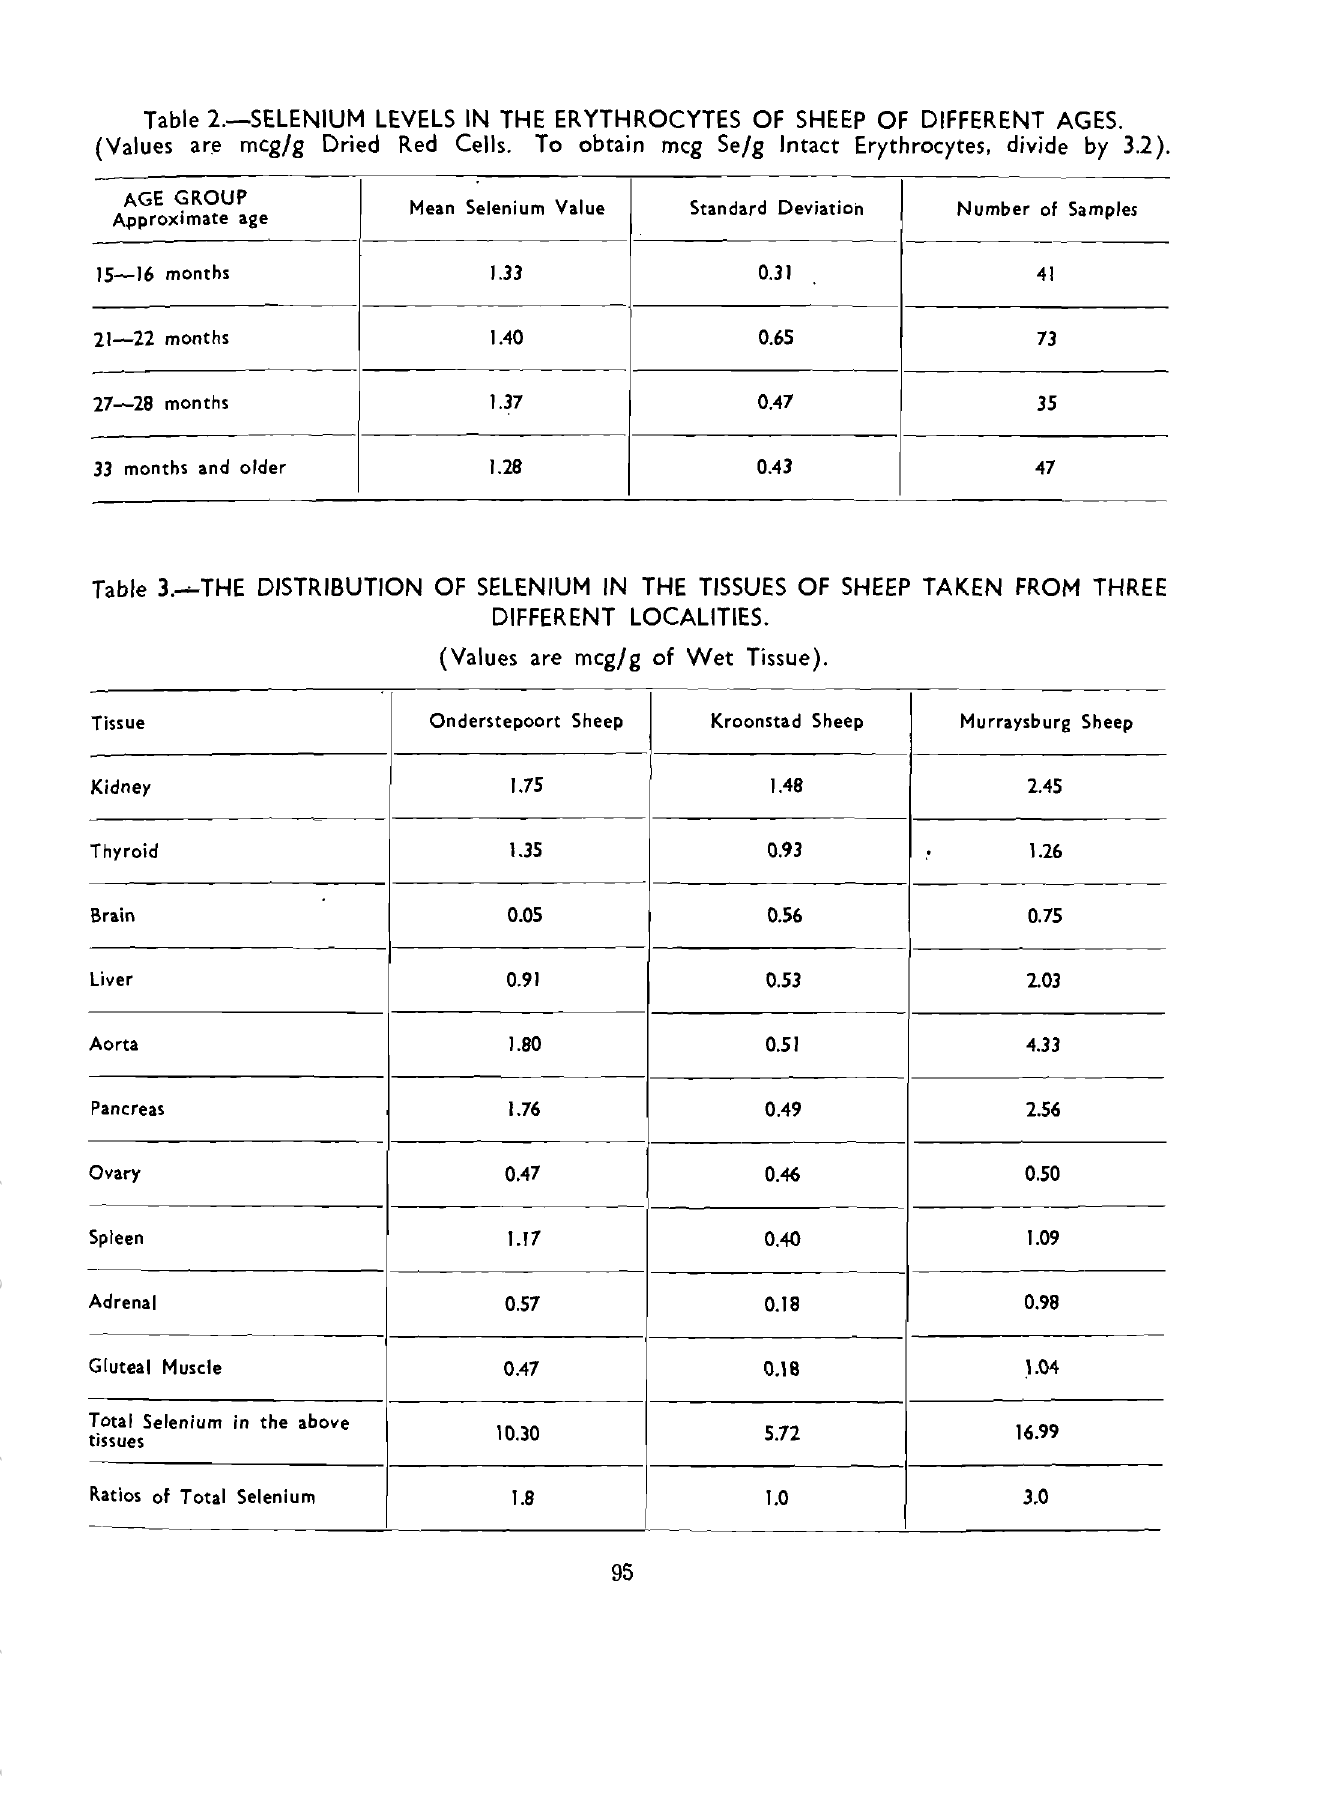
Table 3.-THE DISTRIBUTION OF SELENIUM IN THE TISSUES OF SHEEP TAKEN FROM THREE DIFFERENT LOCALITIES. (Values are mcg/ g of Wet